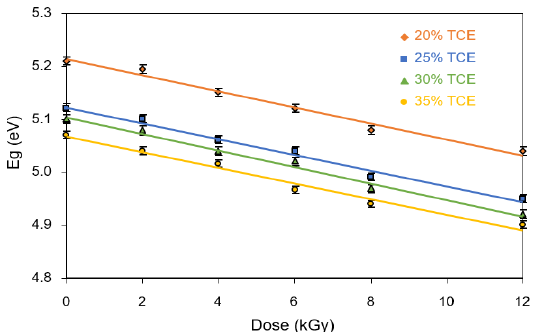
Figure 12. Variation of the direct energy band gaps with dose for PVA-TCE-CT polymer films at different TCE compositions.